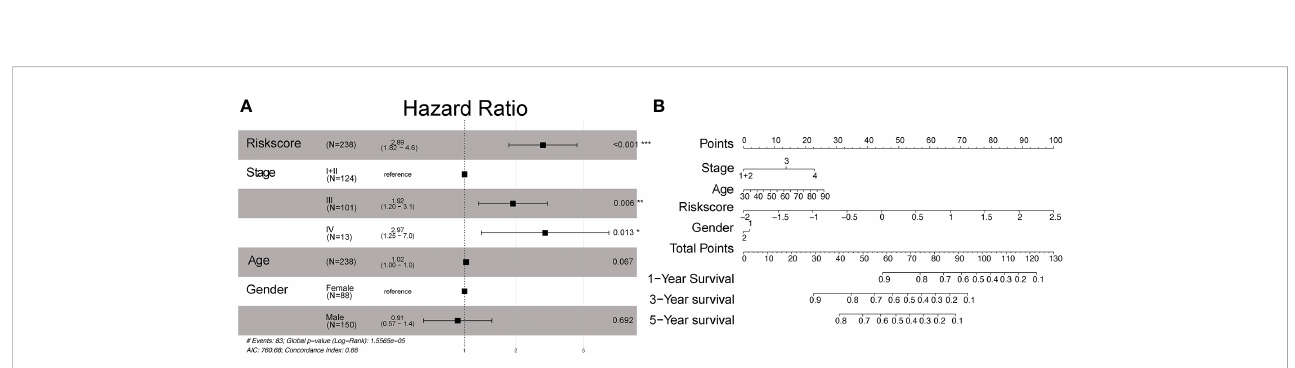
FIGURE 4 Multivariate Cox proportional hazard models of known clinical risk factors. (A) Forest plot of the multivariate Cox regression analysis in gastric cancer training set. (B) Establishment of the nomogram predicting OS for gastric cancer patients in the training cohort. The nomogram plot was built based on four prognostic factors in gastric cancer. *P<0.05; **P<0.01; and